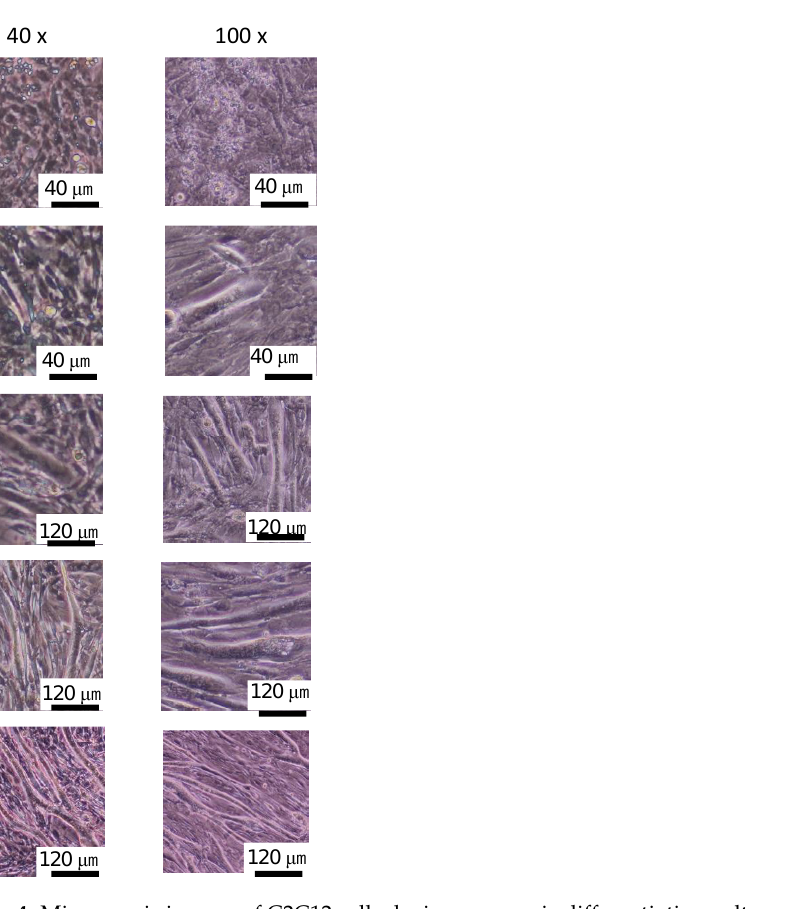
Figure 5. Change in major axis of C2C12 cells during myogenic differentiation culture. Mean +/ − SD, n = 25.